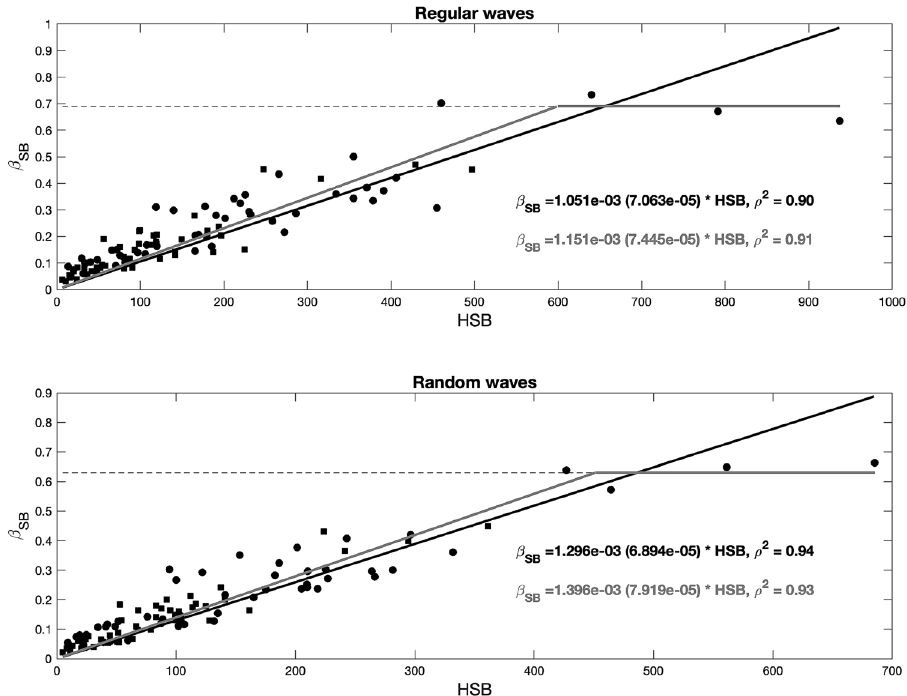
Figure 7. Wave damping coefficient, β SB , as a function of the hydraulic standing biomass, HSB , under all regular (top panel) and random (bottom panel) wave conditions. Both panels show linear fitting results obtained without considering the saturation point, indicated by the black solid line, and those obtained considering the saturation point, indicated by the gray solid line. The black dashed line indicates the saturation point. 95% confidence interval is shown in brackets and correlation coefficient ( ρ 2 ) for each fit is also